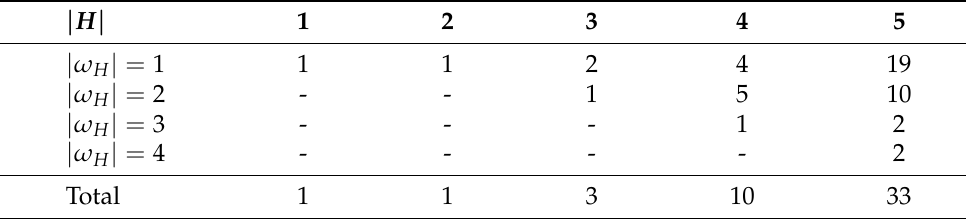
Table 2. Number of non-isomorphic G -hypergroups with | H | ≤ 5, depending on the size of their